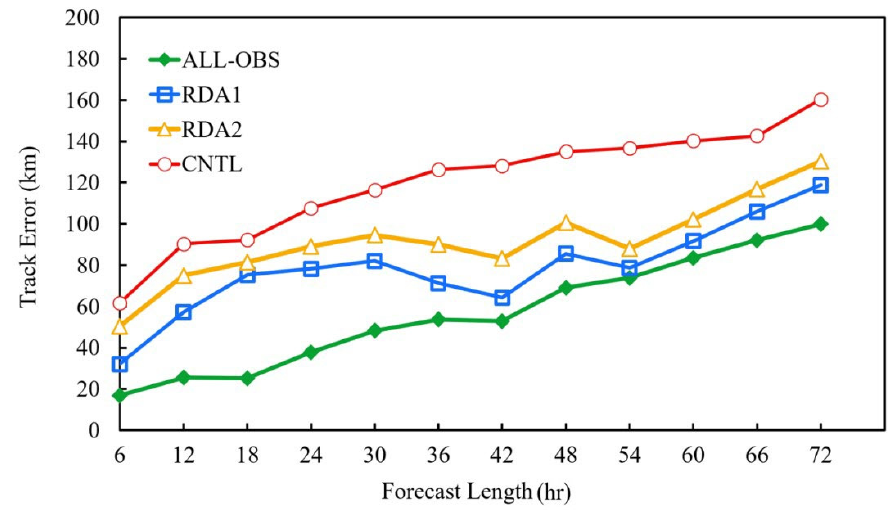
Figure 4. The tracking errors in kilometers (km) over time for the different assimilation experiments.